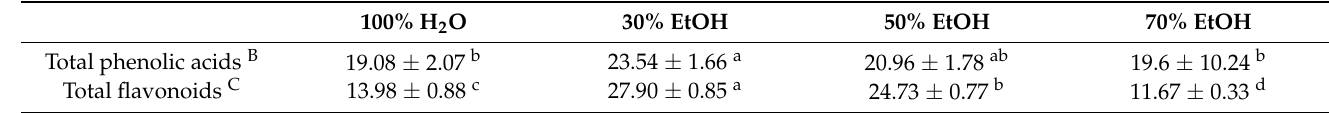
Table 2. Effect of pure water and different ethanol proportion on the contents of total phenolic acids and total flavonoids in C. osmophloeum leaves A